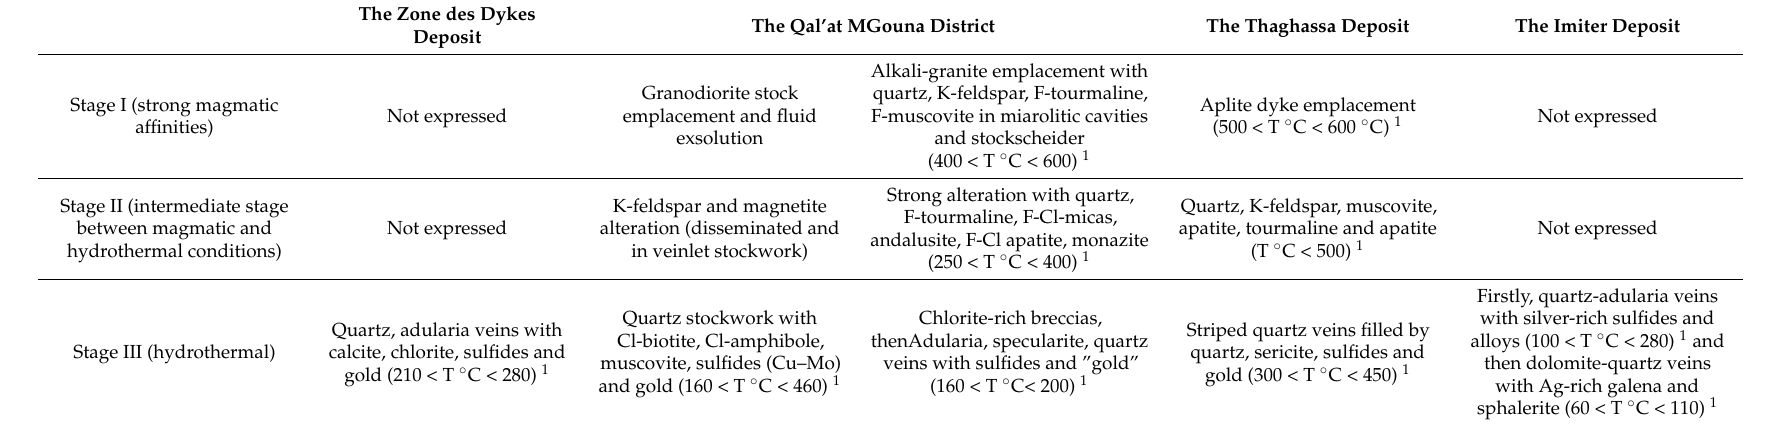
Table 1. Synthetic table summarizing the magmatic-hydrothermal features of main ore deposits of the Saghro